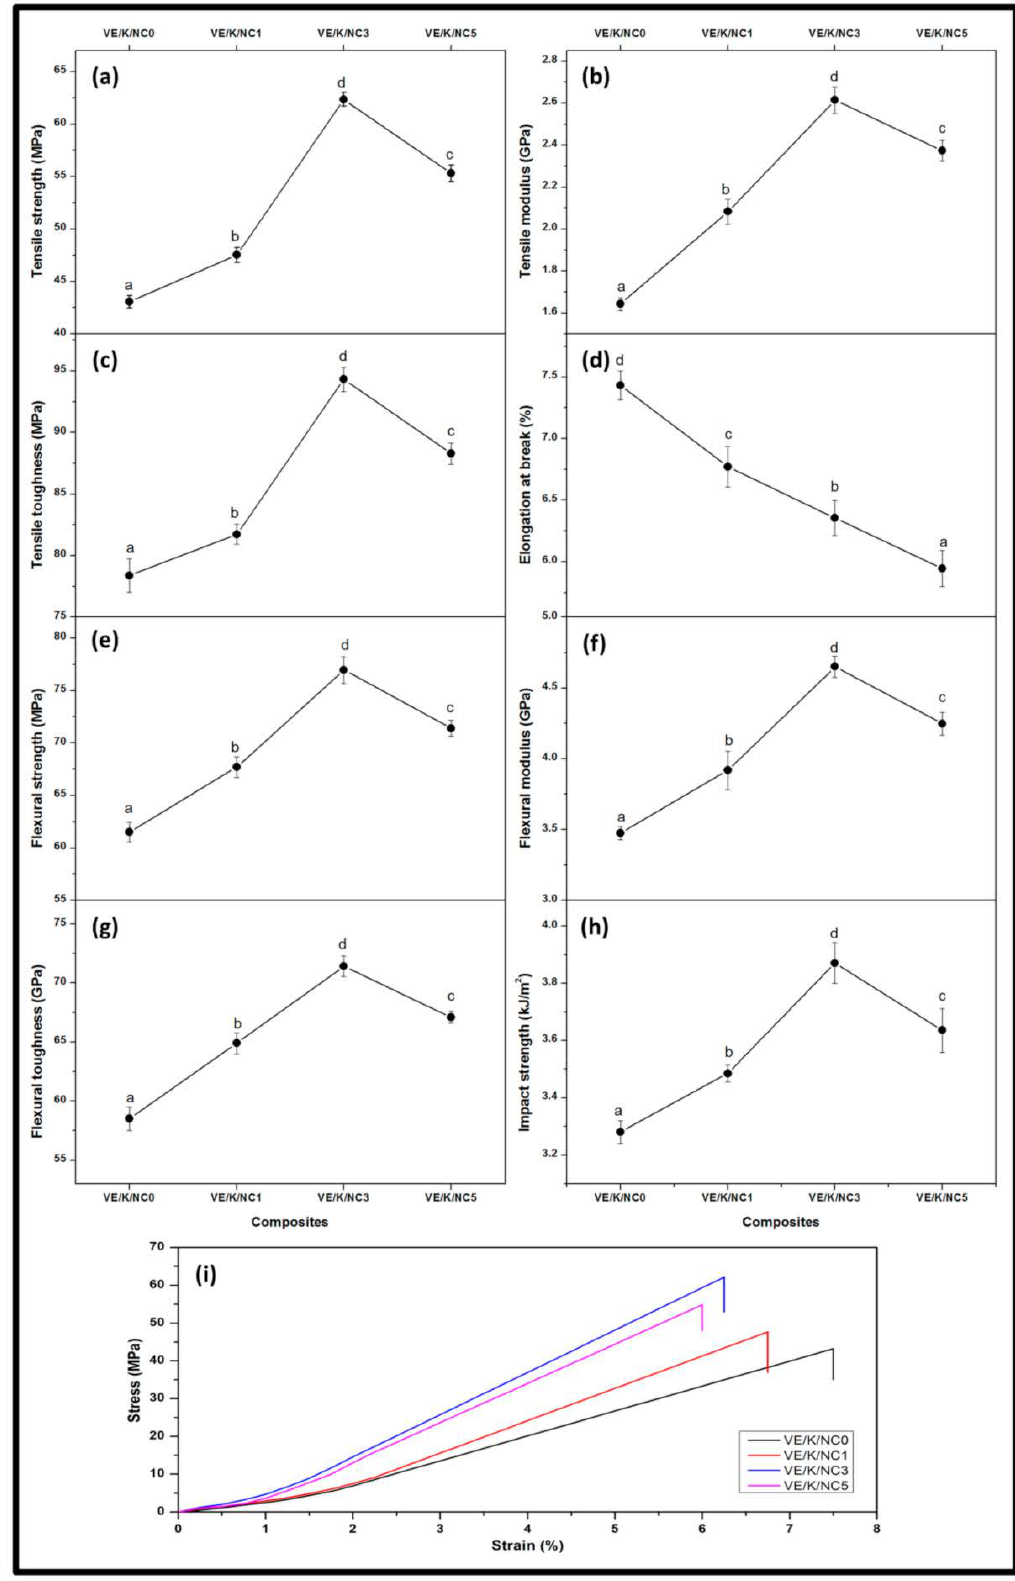
Figure 5. Mechanical properties of ( a ) tensile strength, ( b ) tensile modulus, ( c ) tensile toughness, ( d ) elongation at break, ( e ) flexural strength, ( f ) flexural modulus, ( g ) flexural toughness, ( h ) impact strength, and ( i ) stress-strain curves of nanocomposites. Values are presented as mean with one standard deviation error bar. The different superscript letters between data bars represent significant differences ( p <